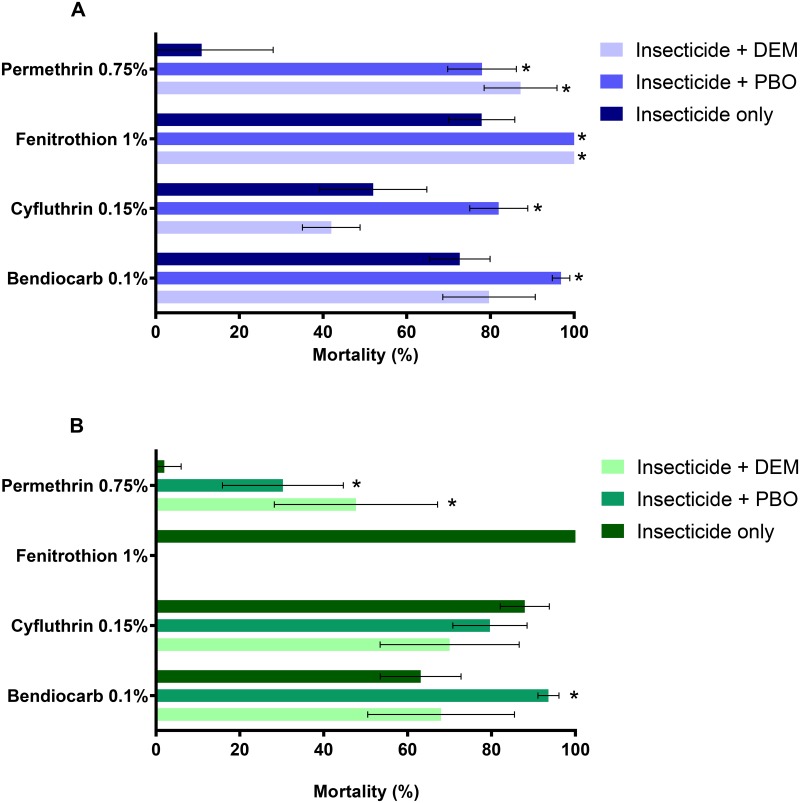
Susceptibility levels of Ae. aegypti from Funchal (A) and Paúl do Mar (B) to insecticides.* Significant differences in mortality rates between exposures with and without synergists (Fisher’s exact test, P< 0.05). The error bars represent standard deviation.